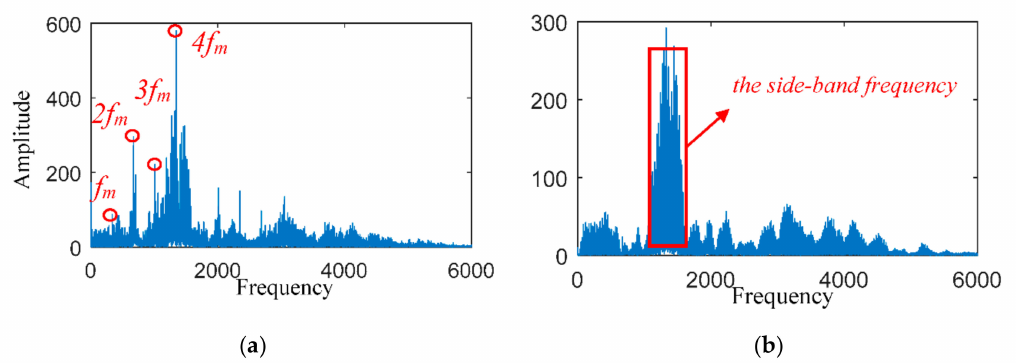
Figure 4. Frequency spectrum results with spectral subtraction denoising: ( a ) frequency spectrum of the original signal; and ( b ) frequency spectrum of the processed signal.